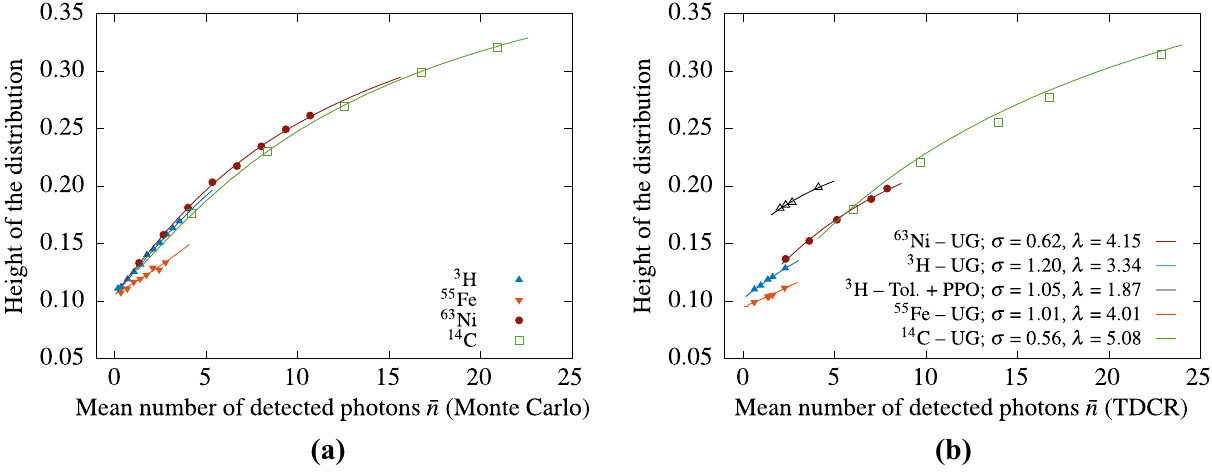
Figure 5. Height of the normalized cross-correlation spectra as a function of the mean number of detected photons. The data points on the left are generated by the Monte Carlo code and the lines are calculated from µ . The data points on the right are from TDCR the analytical equation with the same parameters at � t = 3 55 64 3 14 measurements of H, Fe, Ni and C in Ultima Gold and H in toluene + PPO cocktails. The fit is done with µ in order to obtain the optimal (cid:31) and σ parameters. the analytical equation at � t =